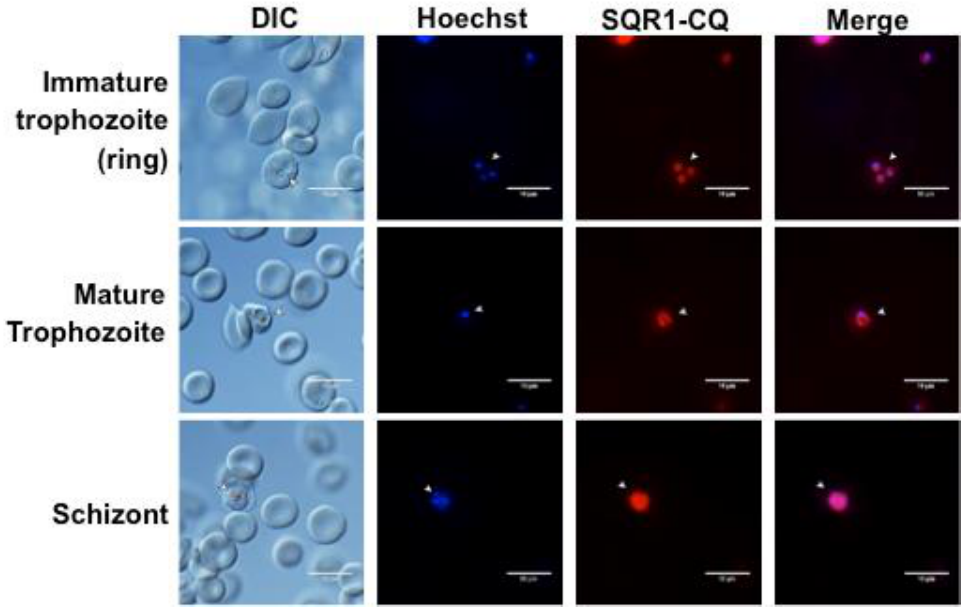
Figure 1. Squaraine dye coupled with chloroquine (SQR1-CQ) labelling of CQ-sensitive P. falciparum . Mixed in vitro cultures of 3D7 P. falciparum were co-labelled with nuclear stain Hoechst 33342 and SQR1-CQ, before analyzing via confocal microscopy. We observe multiple stages of 3D7 (arrowheads) exhibiting uptake and labelling with both dyes. Hoechst 33342 indicated localization of nuclei in P. falciparum stages while SQR1-CQ was shown to specifically sequester within cytoplasmic space of 3D7 and not in RBCs. Surrounding unparasitized RBCs we not observed to retain SQR1-CQ or Hoechst 33342. Bar = 10 µm.